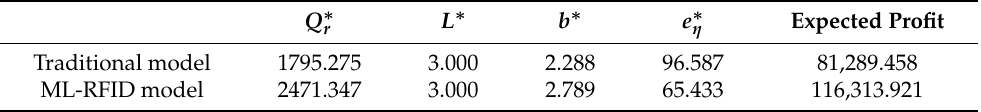
Table 3. Optimal solutions for both the